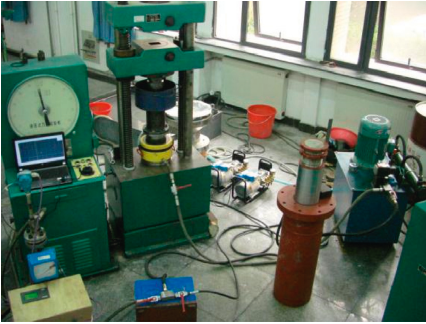
Figure 2: The experimental